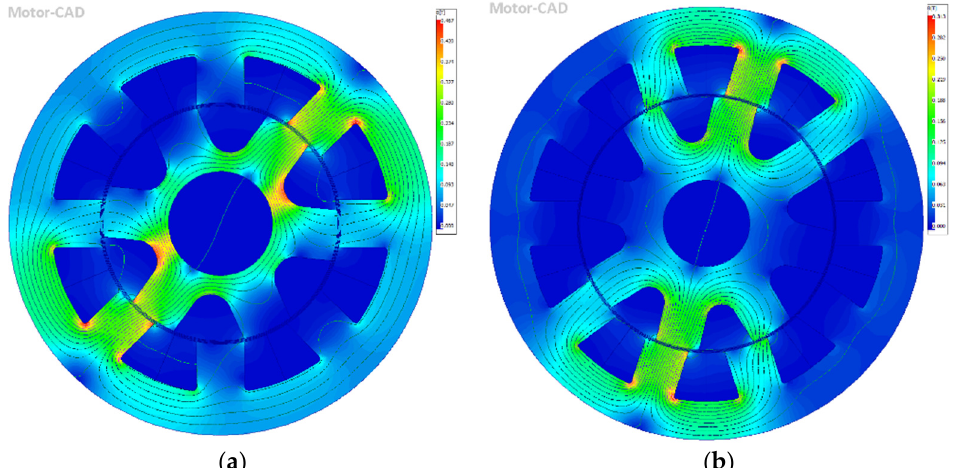
Figure 21. FEM analysis results — the distribution of related magnetic lines for an electric machine: ( a ) 8/6; ( b ) 10/8.